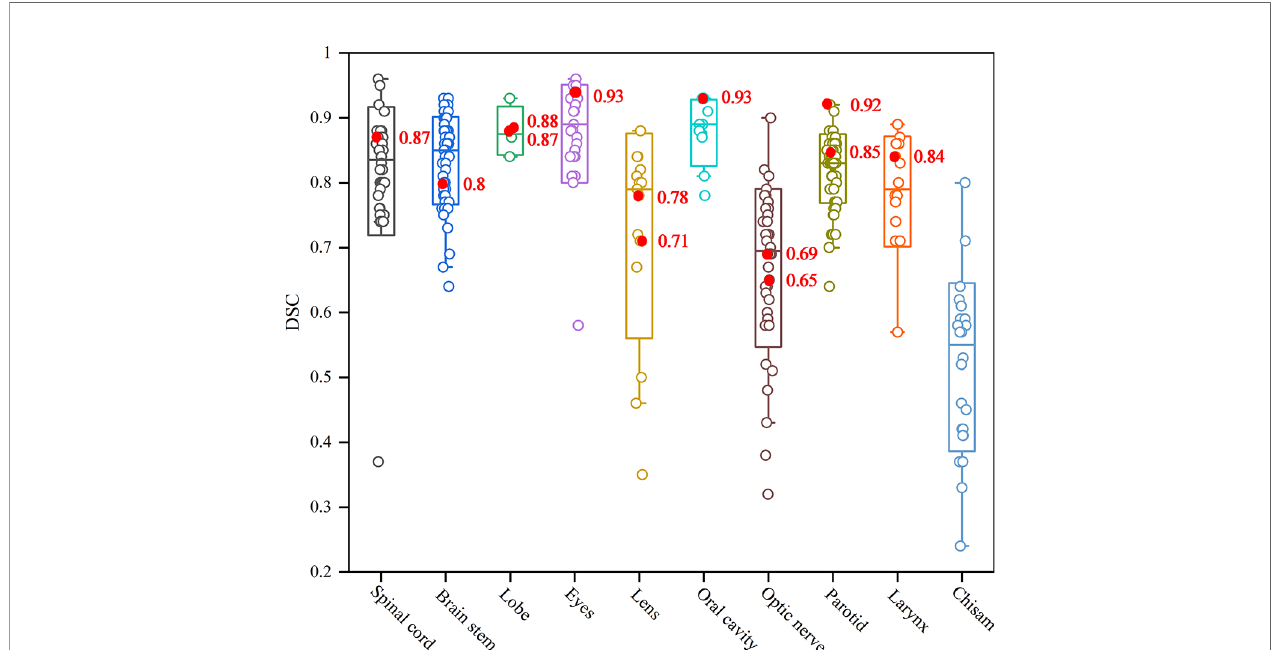
FIGURE 6 | The box plot results of auto-segmentation of OARs in HNC reported in terms of the Dice coef fi cient (22). The red mark dots are the Dice coef fi cient in our second phase training